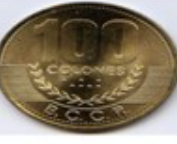
Figure 4. Costa Rican